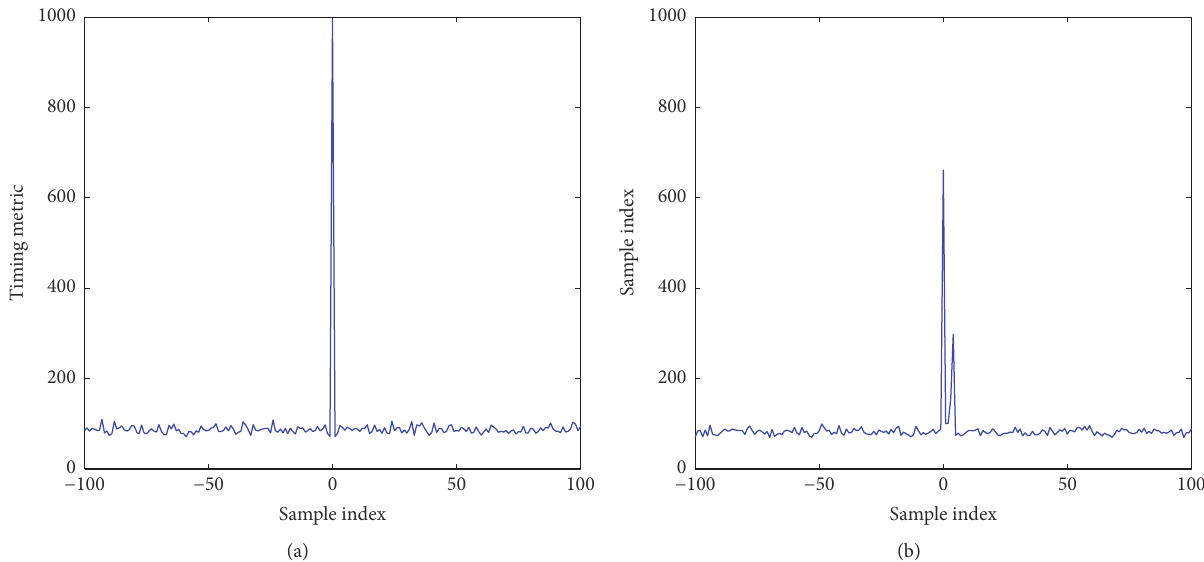
Figure 2: Timing metrics of the proposed method ( 𝑁 = 1024 and length of the cyclic prefix is 128) (a) without noise and channel distortion and (b) in a 5-tap Rayleigh fading